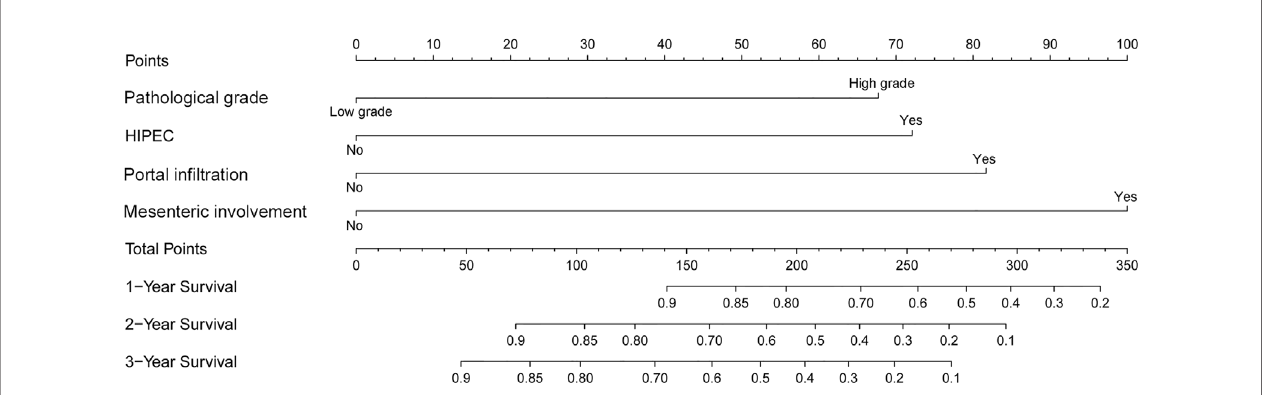
FIGURE 5 | A nomogram to predict the 1-, 2-, and 3-year survival rates in PMP patients. It is used by drawing a line perpendicular from the corresponding axis of each risk factor until it reaches the top line labeled “ Points. ” Then, the number of points for all risk factors is summed, and a line is drawn that descends from the axis labeled “ Total points ” until it intercepts each of the survival axes to determine the 1-, 2-, and 3-year survival